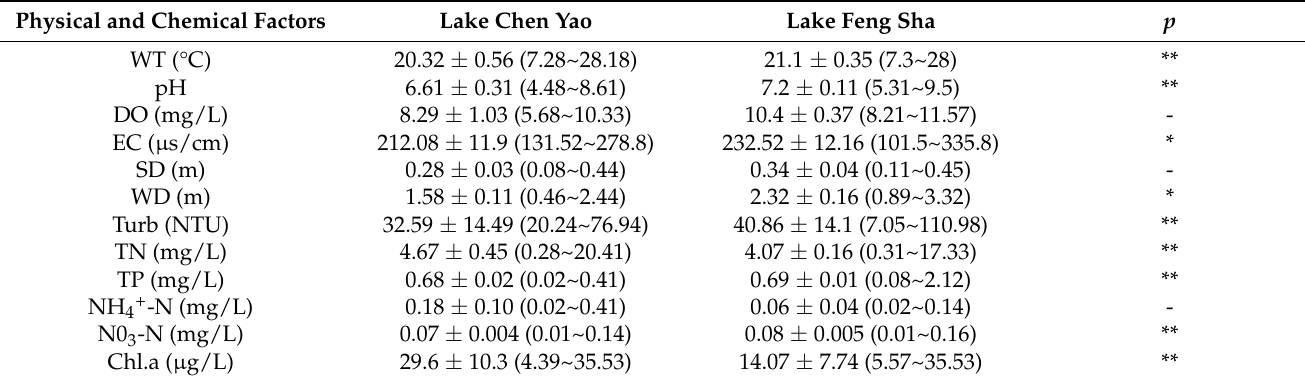
Table 1. Physical and chemical factors of Lake Chen Yao and Lake Feng Sha (mean ± standard deviation).